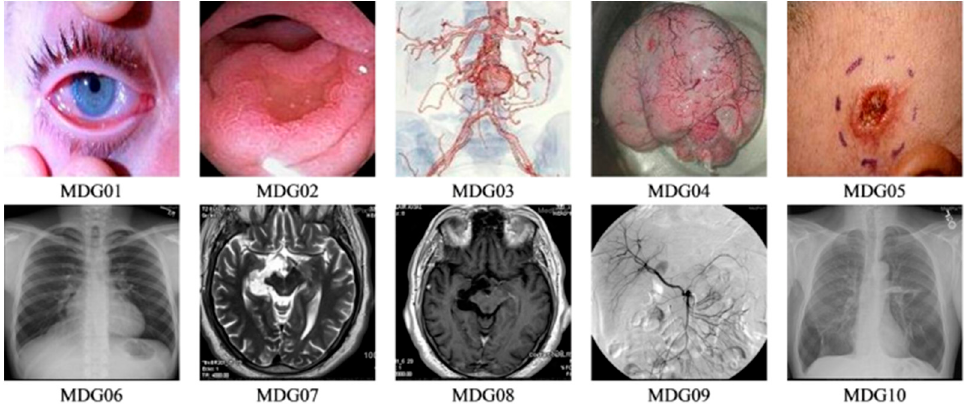
Figure 3. Dataset showing carrier and secret images used in the experiments.